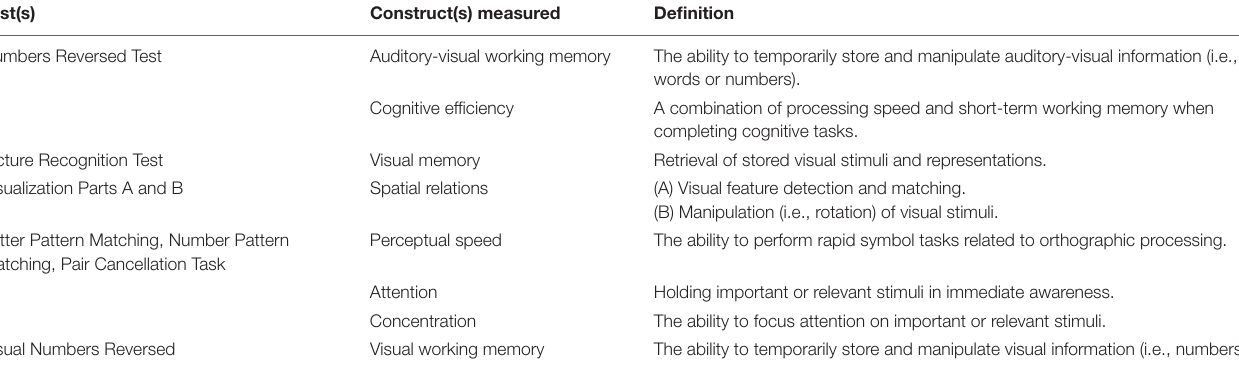
TABLE 2 | Description of constructs measured by cognitive test.